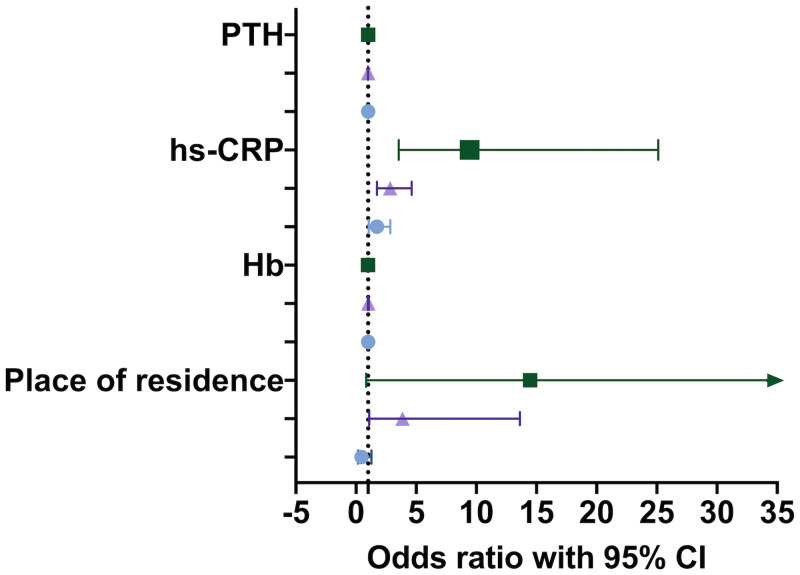
Multiple logistic regression analysis of factors influencing skin itching in patients with uremic pruritus.The error bars represent the lower and upper limits of the 95% confidence interval. The symbol is a circle for mild itching, a triangle for moderate itching, and a square for severe itching. The dashed line in the figure indicates that the odds ratio is equal to 1.